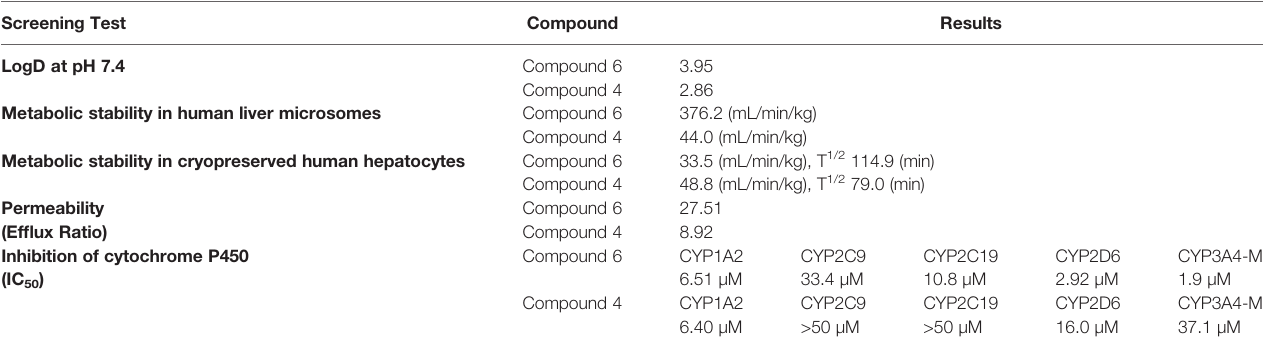
TABLE 2 | Pharmacokinetic pro fi le of compounds 4 and 6 . Screening Test